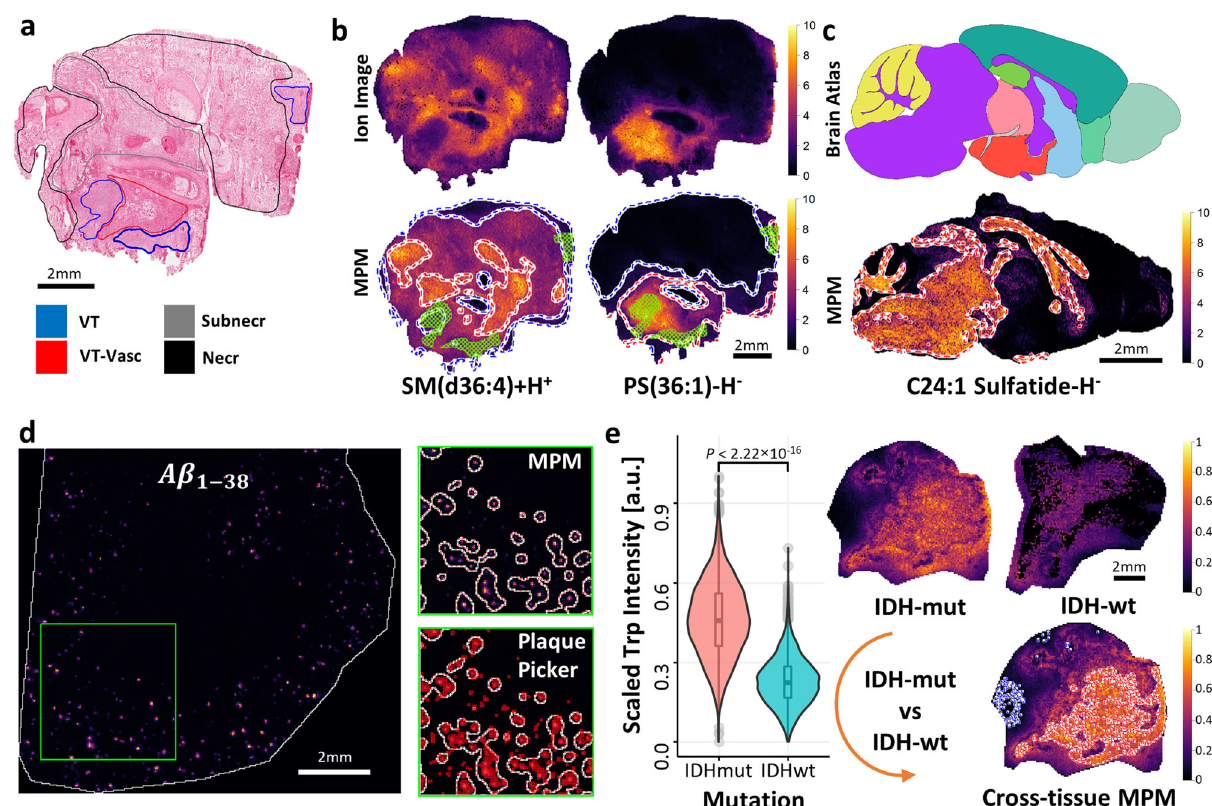
Fig. 3 | Molecular probabilistic maps (MPM) for spatial probabilistic mapping of MPM hotspot and coldspot contours indicating areas of MOI ’ s increased relative spatial abundance or de fi ciency in tissue, respectively. a Hematoxylin and eosin (H&E)-stained human glioblastoma (GB) tissue section (VT: vital tumor; VT-Vasc: vascularized vital tumor; Subnecr: pre-necrotic; Necr: necrotic) . b Com- parisonofMALDI-MSIionimagesandcorrespondingMPMhotspot(red/white)and coldspot (blue/white) contours of SM(d36:4)[M+H + ] and PS(36:1)[M − H] − (FDR ≤ 0.10; FTICR-MSI) relative to VT regions (green mesh). c MPM of m/z 888.6240 (C24:1 Sulfatide[M − H] − ; FTICR-MSI), previously reported to be present in the mid- brain and white matter ( fi ber tracts) regions, in a sagittal mouse brain